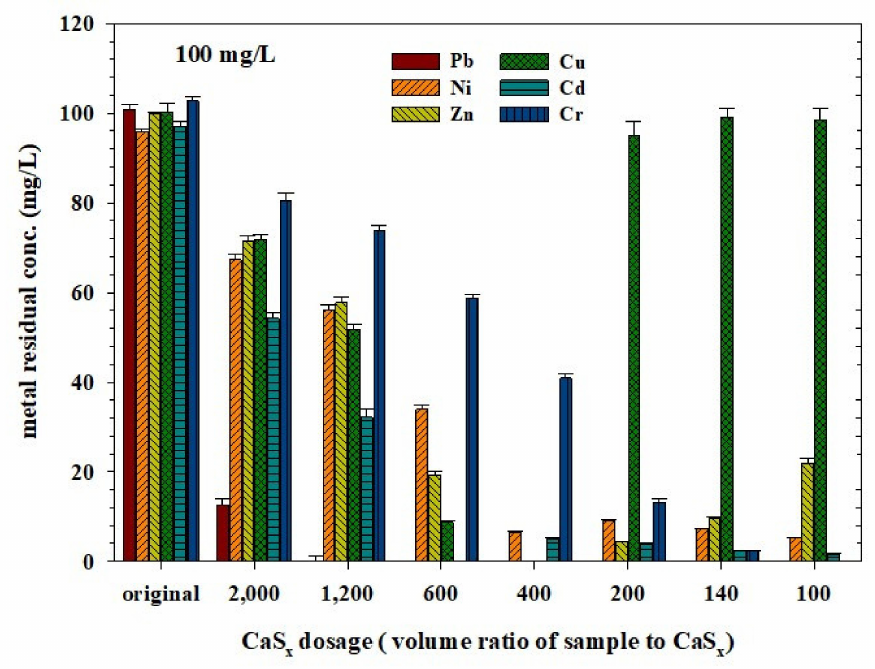
Figure 6. The removal efficiency of calcium polysulfide on various metals at high concentrations (100